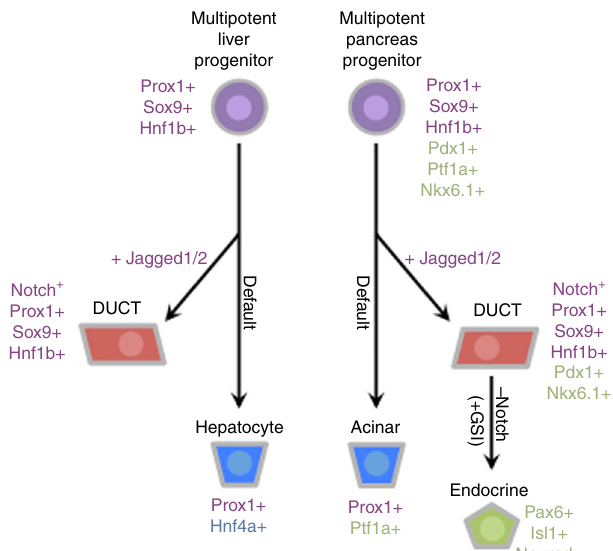
Fig. 6 Model diagram depicting common role for Jagged1b and Jagged2b in lineage speci fi cation of liver and pancreas ducts in zebra fi sh. During organogenesis, multipotent liver and pancreas progenitors, by default, give rise to hepatocytes and acinar cells, respectively. Jagged/Notch signaling is required in both organs for induction of duct lineage speci fi cation from these multipotent precursors. Once Notch signaling is activated in a cell, it contributes exclusively to the duct lineage. In the pancreas, loss of Notch signaling via gamma secretase inhibitors (GSI) from lineage speci fi ed duct cells could lead to their mis-differentiation into endocrine cells. Factors listed in purple demonstrate genetic similarities of cell types between the pancreas and liver. In green and blue are factors speci fi c to the pancreas